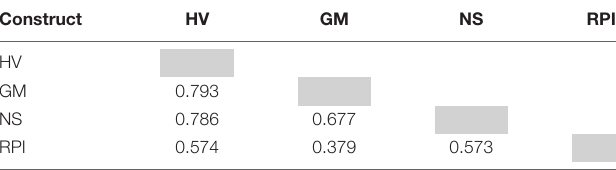
TABLE 6 | Dimension effect for the second-order formative constructs. Construct